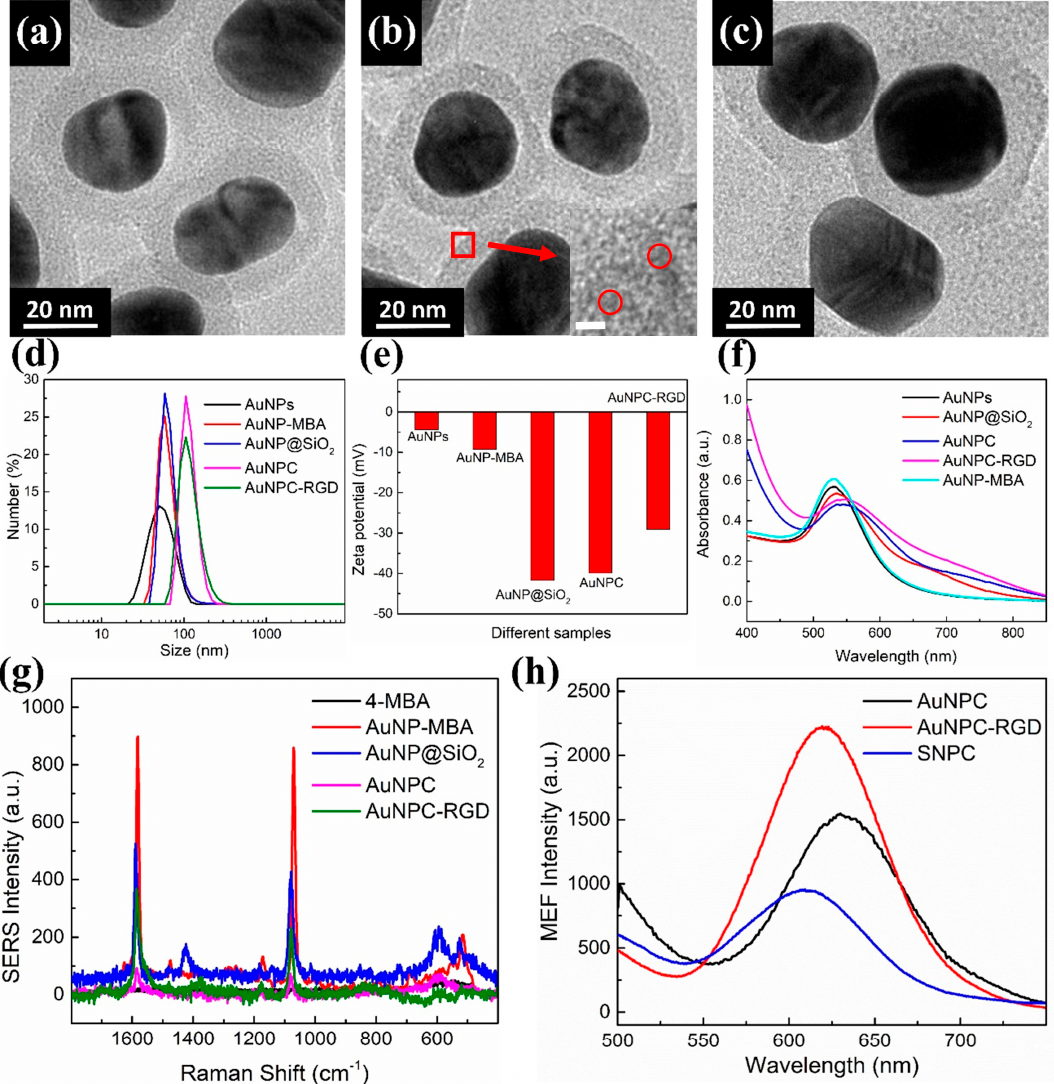
Figure 2. Characterization of the bifunctional nanoprobes. ( a – c ) TEM images of the AuNP@SiO 2 , AuNPC and AuNPC-RGD; ( d – e ) Size distributions and zeta potentials of the AuNPs, AuNP-MBA,